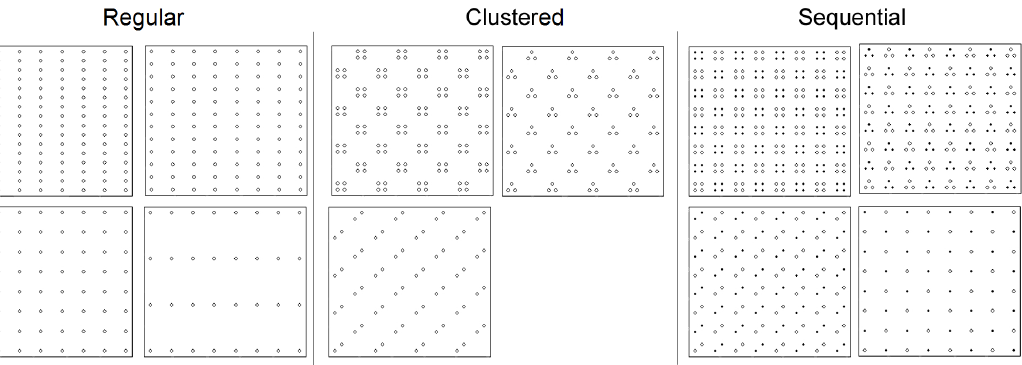
Figure 4. Trap configuration and number of traps generated eleven designs. Eleven trap designs were evaluated by varying the regular, clustered, and sequential trap arrangements for J=128, 96, and 64 traps. Only the regular and sequential arrangements were evaluated for J=32 traps since the clustered arrangement with one trap per cluster was equivalent to the regular arrangement. Trap spacing did not change when traps were in the clustered and sequential arrangements.